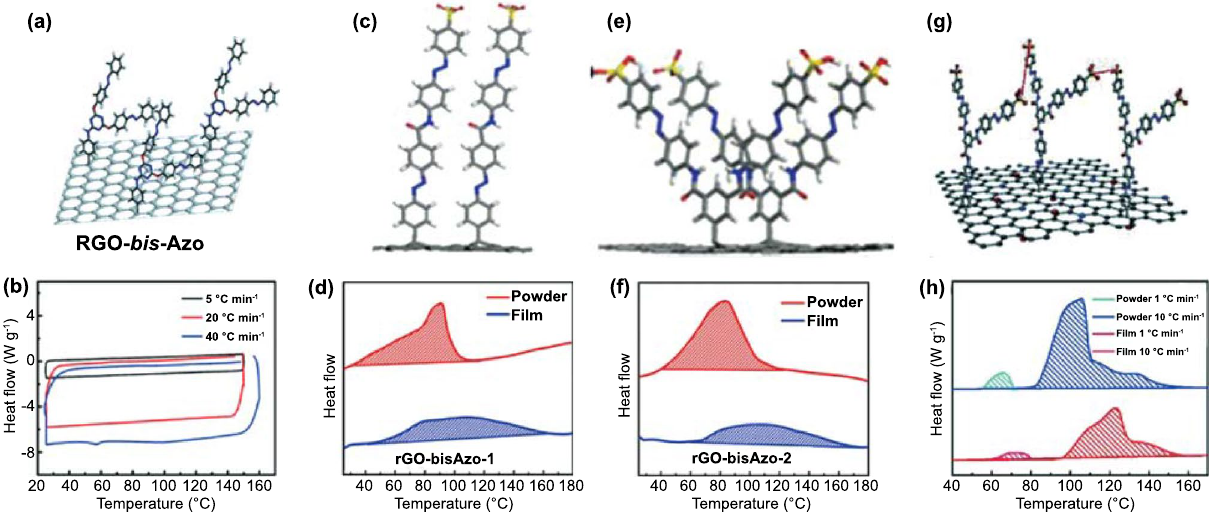
Fig. 12 a , b Chemical structure and DSC traces at the cis -rich photostationary states after the irradiation by UV light with the first heating at different rates of RGO-bis-Azo [123]. c–f Chemical structures and DSC traces in the first heating stage of RGO-bisAzo-1 and RGO-bisAzo-2 [107]. g , h Chemical structure and DSC traces of the tri-Azo1:68/RGO powder and film at heating rates of 1 and 10 °C min. −1 , respectively